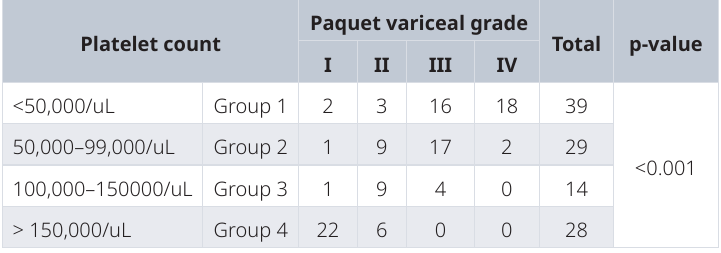
Table 1. Association of platelet count group with grades of esophageal varices.